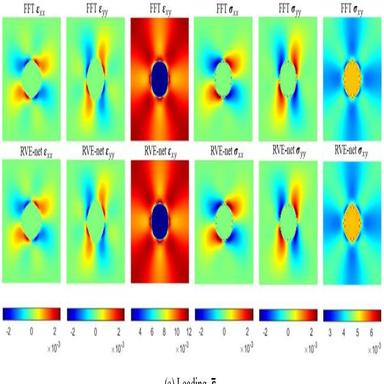
Errors of the strain predicted by RVE-net for the three loading conditions.